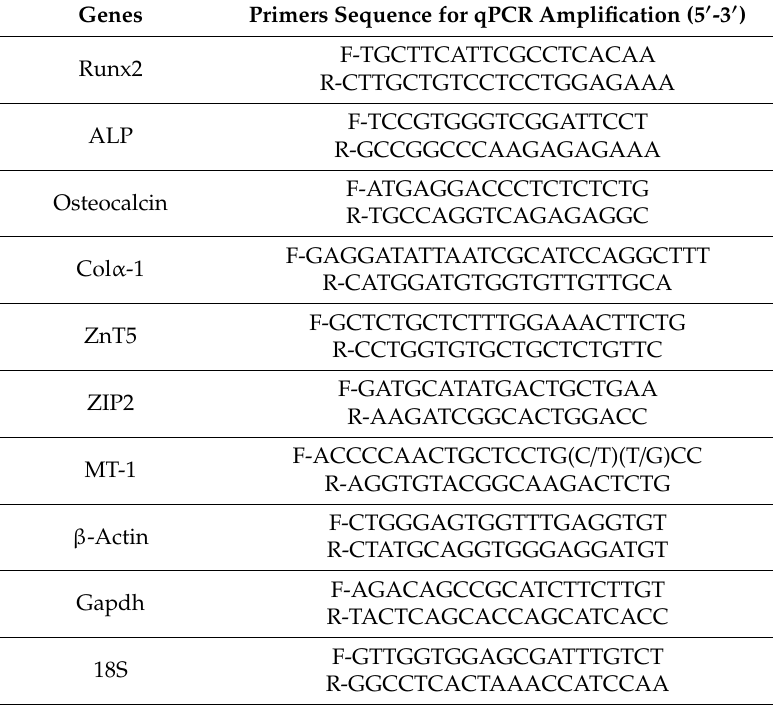
Table 4. Primers used for realtime